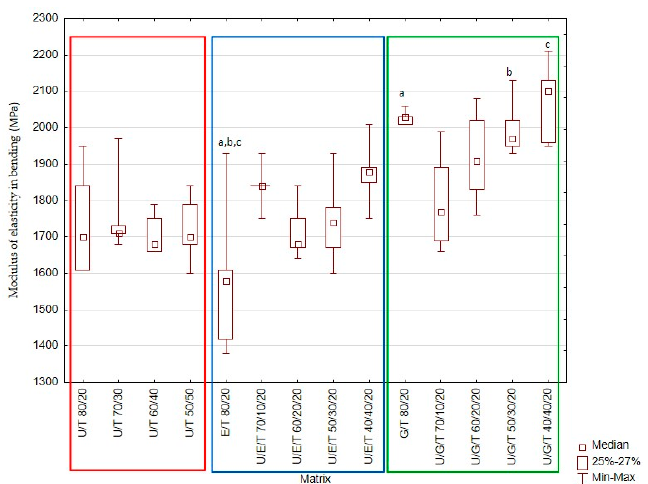
Figure 2. Box-and-whisker plot of modulus of elasticity in bending. For variables with the same letter (a,b,c), the difference is statistically significant ( p ≤ 0.05).The modulus of elasticity in bending (FM) was also determined (Figure 2). Median FM values ranged from 1.58 GPa (Bis-EMA/TEGDMA 80/20 wt.%) to 2.1 GPa (UDMA/Bis-GMA/TEGDMA 40/40/20 wt.%) (Figure 2). These differences were statistically significant (Kruskal–Wallis test; p -value = 0.0000). Based on the multiple comparisons of mean ranks for all groups, statistically significant differences were also found between Bis-EMA/TEGDMA 80/20 wt.% and Bis-GMA/TEGDMA 80/20 wt.% ( p -value = 0.010261); Bis-EMA/TEGDMA 80/20 wt.% and UDMA/Bis- GMA/TEGDMA 50/30/20 wt.% ( p -value = 0.044215); Bis-EMA/TEGDMA 80/20 wt.% and UDMA/Bis-GMA/TEGDMA 40/40/20 wt.% ( p -value = 0.044215). In the case of Bis-EMA/TEGDMA 80/20 wt.%, the FM value was lower than those in Bis-GMA/TEGDMA 80/20 wt.%, UDMA/Bis-GMA/TEGDMA 50/30/20 wt.%, and UDMA/Bis-GMA/TEGDMA 40/40/20 wt.%. The analysis of the median modulus of elas- ticity in bending, depending on the matrix composition, is presented in Figure 2.